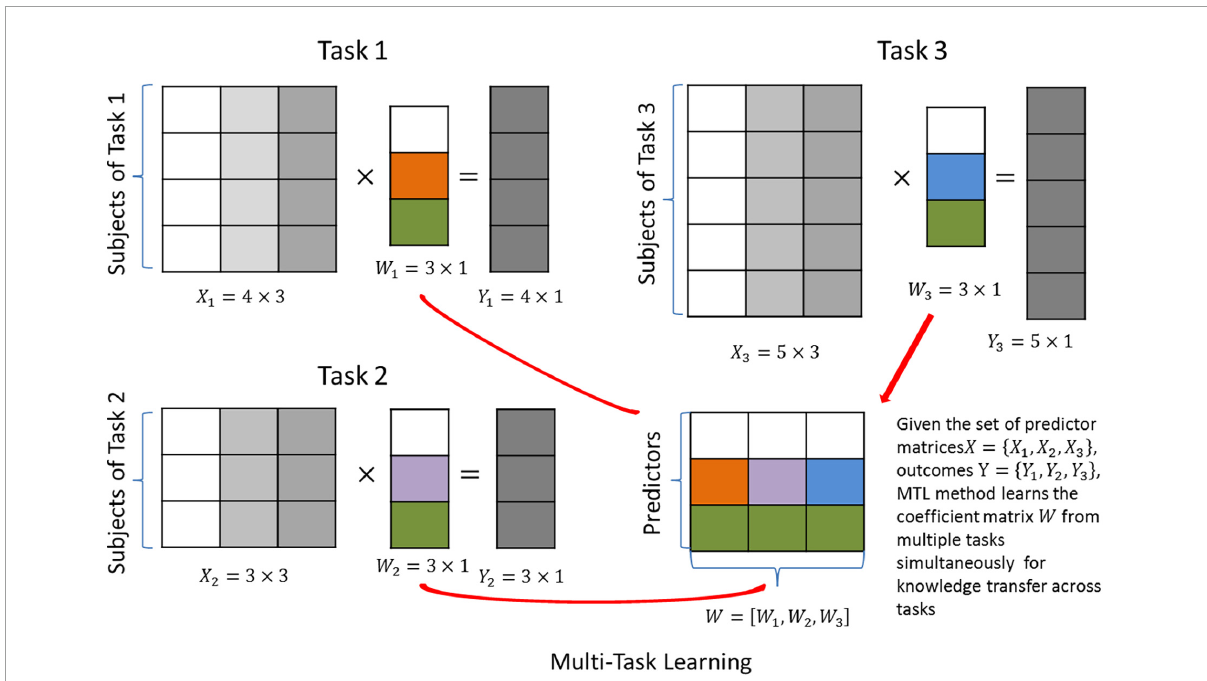
FIGURE2 Graphical illustration of multi-task learning (MTL) with joint predictor selection. Three different tasks are predicted by the same set of predictors. The aim is to identify the coefficient matrix W that maximizes the prediction